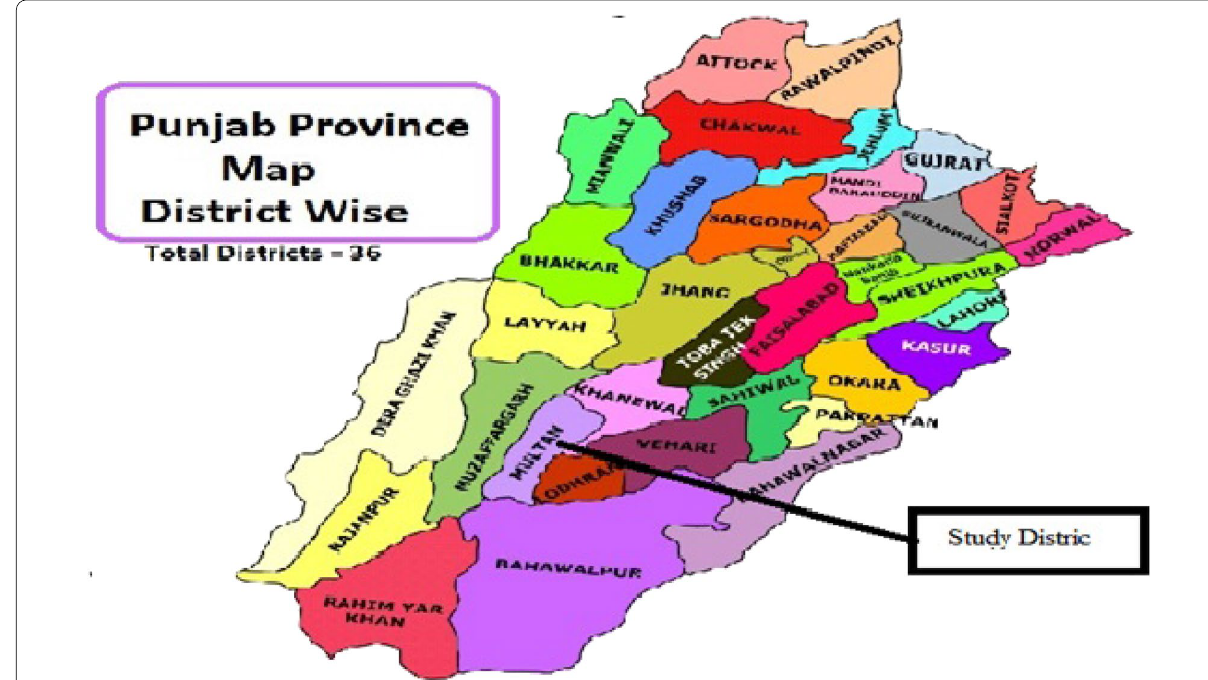
Fig. 2 Study district map of Multan Punjab province of